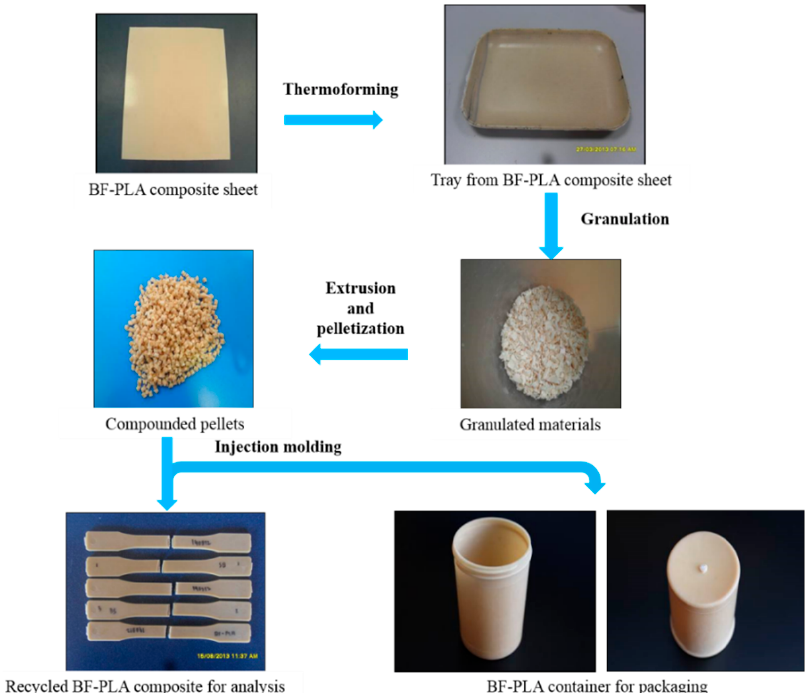
Figure 1. Recycling process of bamboo fabric-reinforced poly(lactic) acid (BF-PLA) composite.